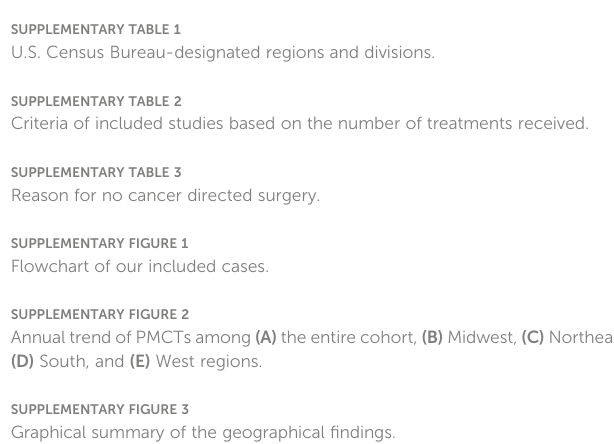
SUPPLEMENTARY TABLE 1 U.S. Census Bureau-designated regions and divisions. SUPPLEMENTARY TABLE 2 Criteria of included studies based on the number of treatments received. SUPPLEMENTARY TABLE 3 Reason for no cancer directed surgery. SUPPLEMENTARY FIGURE 1 Flowchart of our included cases. SUPPLEMENTARY FIGURE 2 Annual trend of PMCTs among (A) the entire cohort, (B) Midwest, (C) Northeast, (D) South, and (E) West regions. SUPPLEMENTARY FIGURE 3 Graphical summary of the geographical fi